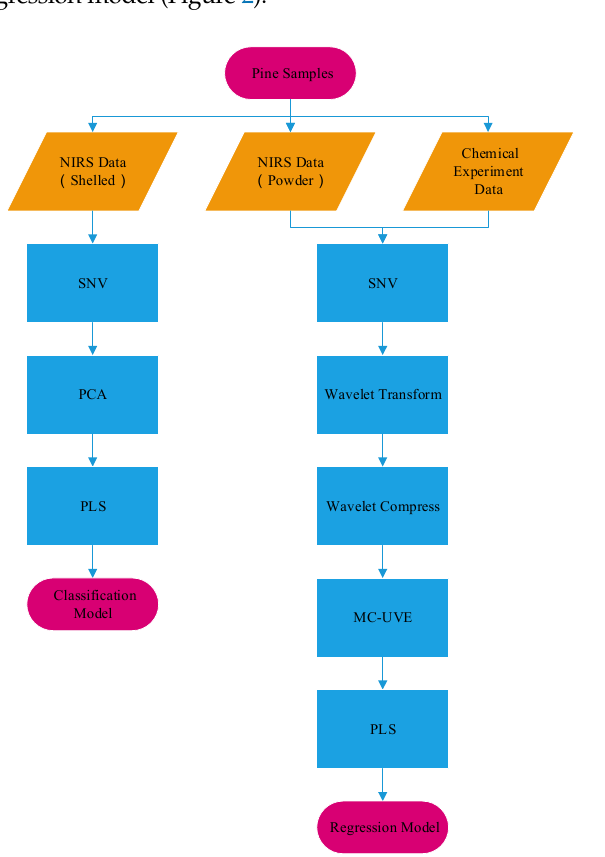
Figure 2. Flowchart of principal component analysis (PCA)–partial least-squares (PLS) classification and wavelet transformation (WT)–Monte Carlo and uninformative variable elimination (MCUVE)–PLS regression models.